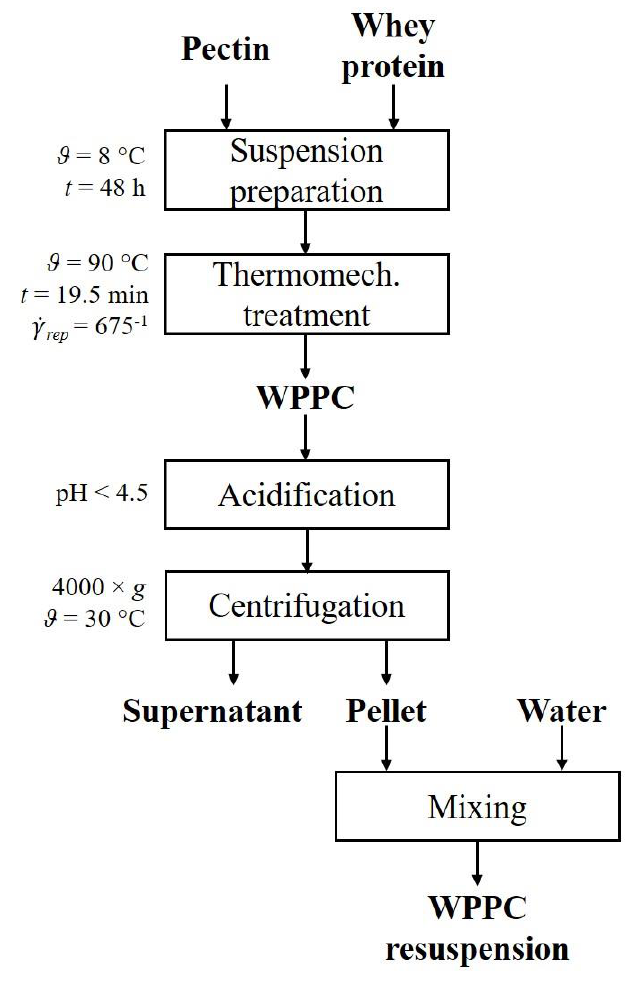
Figure 3. Flow chart of the whey protein pectin complex (WPPC) formation using a scraped-surface heat exchanger (SSHE), their separation and redispersion of the pellet.